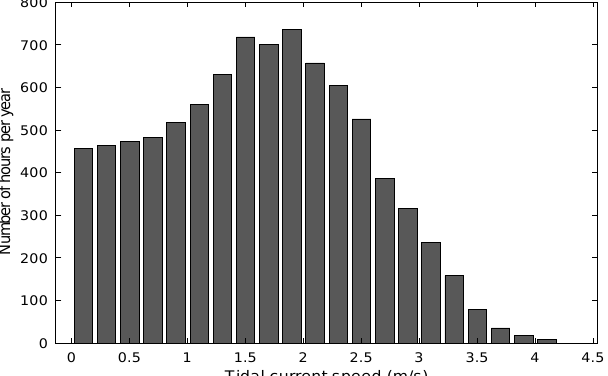
Figure 3. Tidal velocity distribution at EMEC site, Orkney